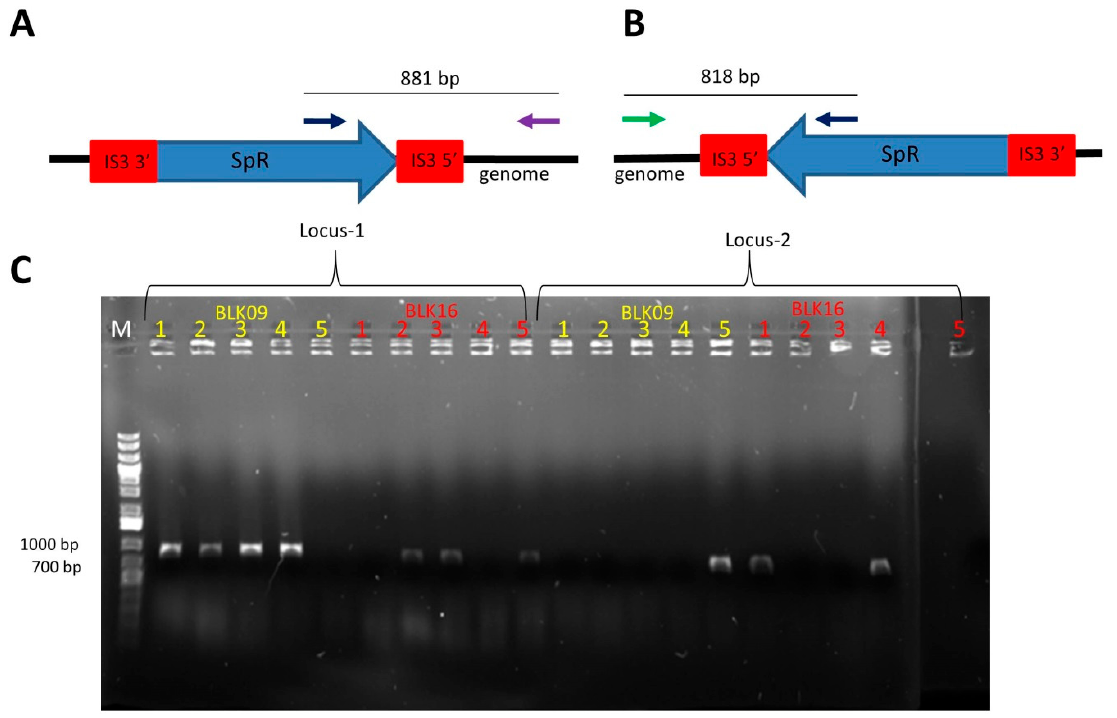
Figure 1. Colony PCR to verify chromosomal SpR integration into IS 3 upon recombineering. ( A ) Expected genetic arrangement and PCR product in the case of successful SpR integration at locus-1. ( B ) Expected genetic arrangement and PCR product in the case of successful SpR integration at locus-2. Black arrow: primer SmFw; purple arrow: primer IS3flanking1; green arrow: primer IS3flanking2; SpR: spectinomycin resistance gene. Red boxes depict IS 3 -homologies. ( C ) Gel electrophoresis of colony-PCR reactions made for screening of 5 E. coli BLK09 and 5 E. coli BLK16 colonies obtained upon recombineering. Primer pairs either specific for locus 1-integration or for locus 2-integration were used in both cases. M: GeneRuler 1 kb Plus DNA Ladder (Thermo Scientific).